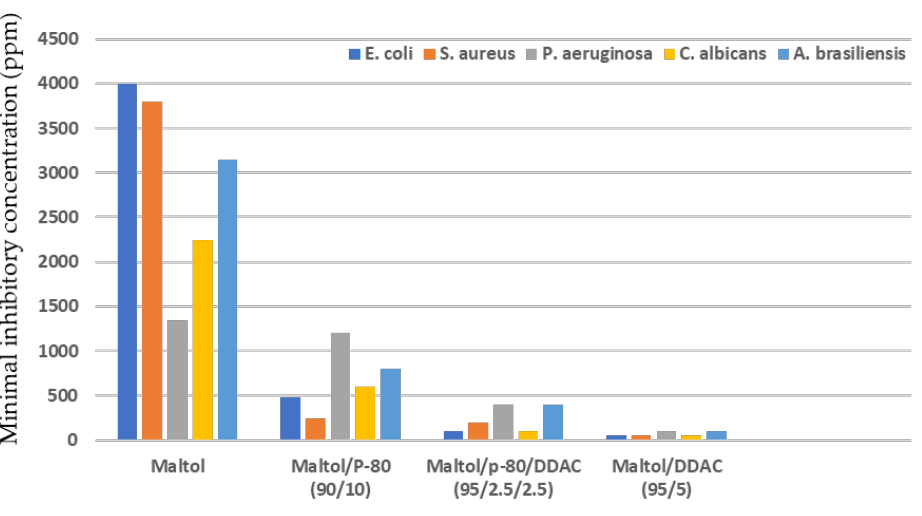
Figure 3. MIC values (ppm) of Maltol, Maltol/P-80 (90/10), Maltol/P-80/DDAC (95/2.5/2.5) and Maltol/DDAC (95/5).